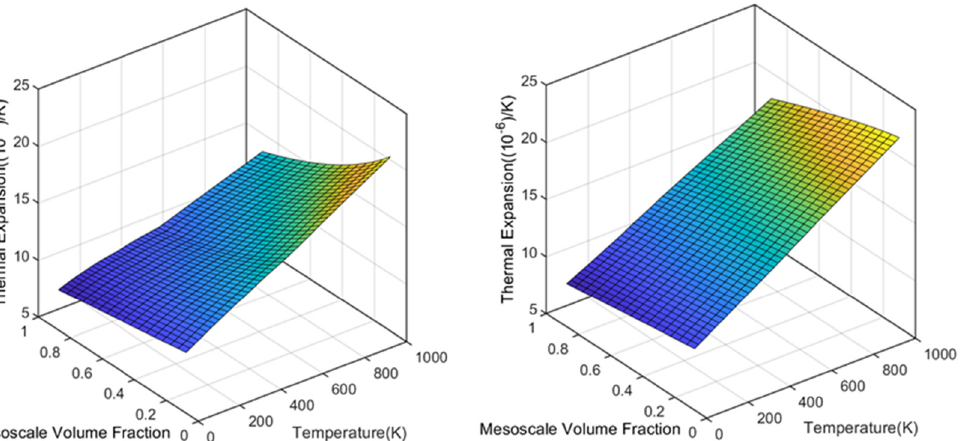
Figure 16: E ff ects of volume fraction of mesoscale homogenized Nb 3 Sn fi lament group and temperature on the global homogenized thermal expansion coe ffi cients, ( Left ) α 11 ⁎ , ( Right ) α α 22 ⁎ 33 ⁎ ( ) . Note: Volume fraction 0.42 is speci fi ed for the microscale homogenized Nb 3 Sn fi lament